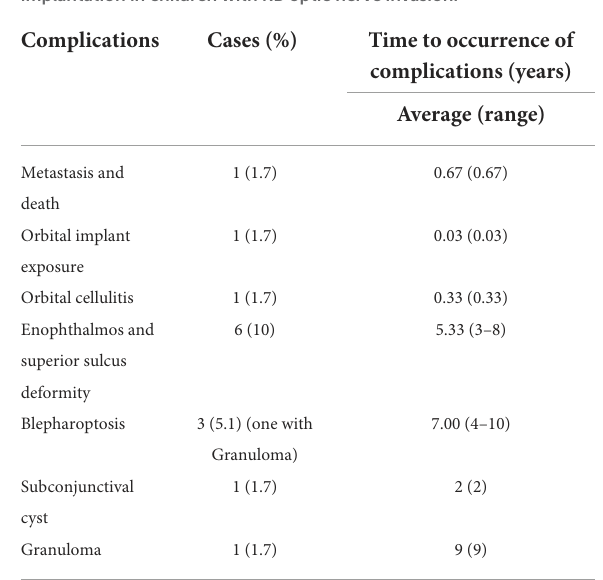
TABLE 3 Complications of enucleation combined with primary orbital implantation in children with RB optic nerve invasion.